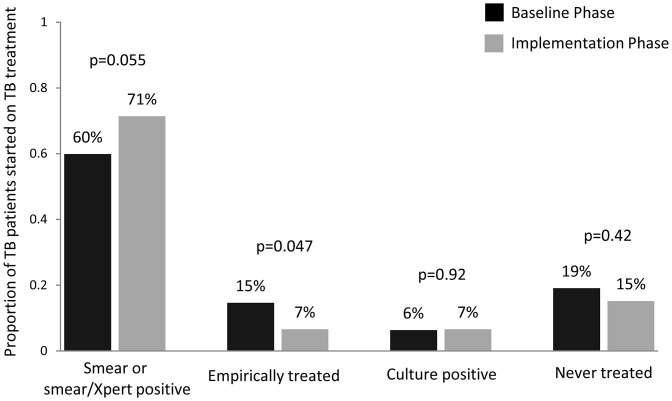
Proportion of TB patients initiated on anti-TB therapy based on test, by study phase.The bars show the proportion of culture-positive TB patients in the baseline vs. the implementation phase started on anti-TB therapy based on rapid test results (i.e., smear in baseline phase and smear/Xpert in implementation phase; 60% vs. 71%, p = 0.055), empirically prior to hospital discharge (15% vs. 7%, p = 0.047), or based on culture results (6% vs. 7%, p = 0.92). The proportion of patients with culture-confirmed TB who were never treated during this study period was similar (19% vs. 15%, p = 0.42).